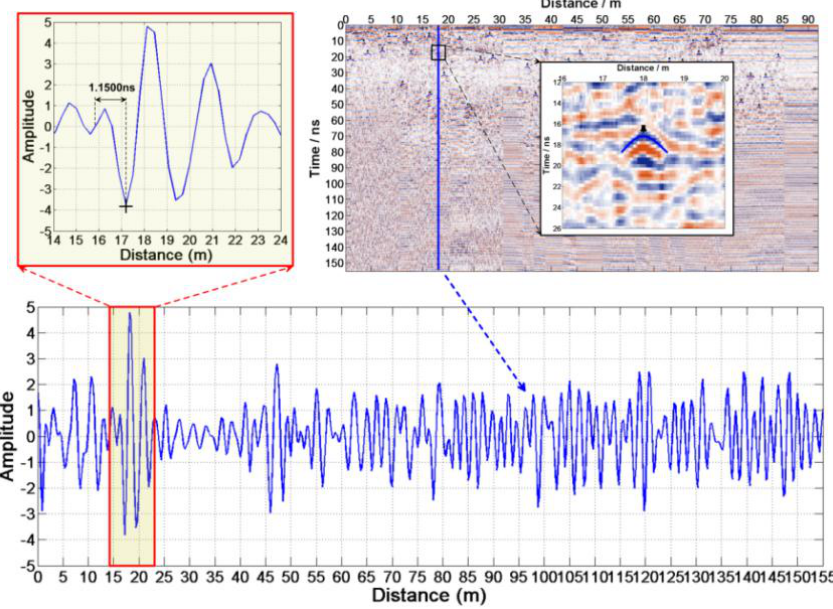
Figure 14. The reflection wavelet waveform of an abnormal body in LPR data.